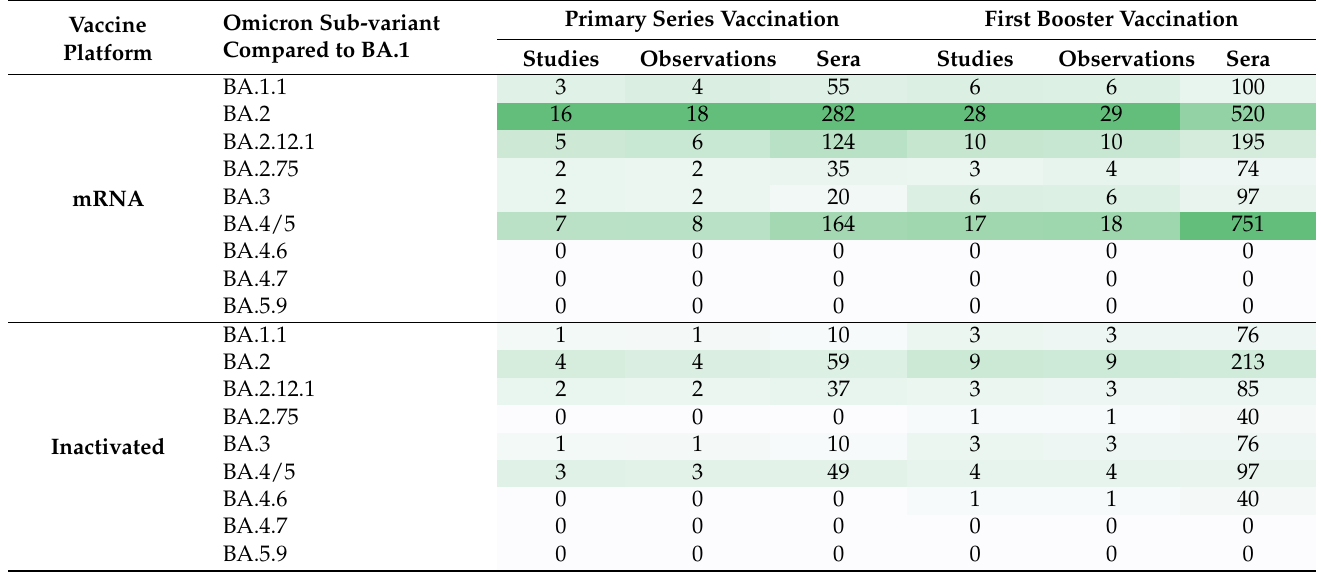
Figure 2. Fold-reduction in neutralization titers relative to the prototype strain for Omicron sub- variants. Primary ( A , B ) series vaccination or first boost vaccination ( C , D ), color coded by platform ( A , C ) or stratified for studies providing multiple variant-specific, paired observations ( B , D ). Every data point represents one observation. Median, IQR and group size is shown. n.d. no data. Table 2. Studies comparing newer Omicron sub-variants to BA.1 sub-variant, availability of evidence vaccine platform and Omicron